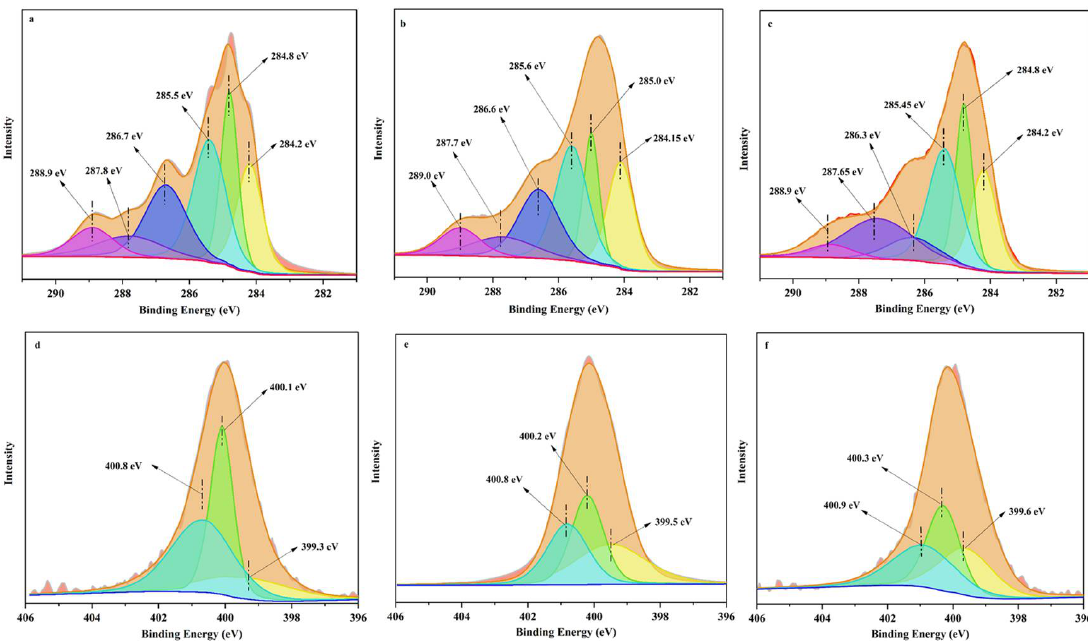
Figure 4. XPS Spectra of C1s and N1s after GBC adsorption. C1s: Pb ( a ), Cd ( b ) and Cu ( c ); N1s: Pb ( d ), Cd ( e ) and Cu ( f ).